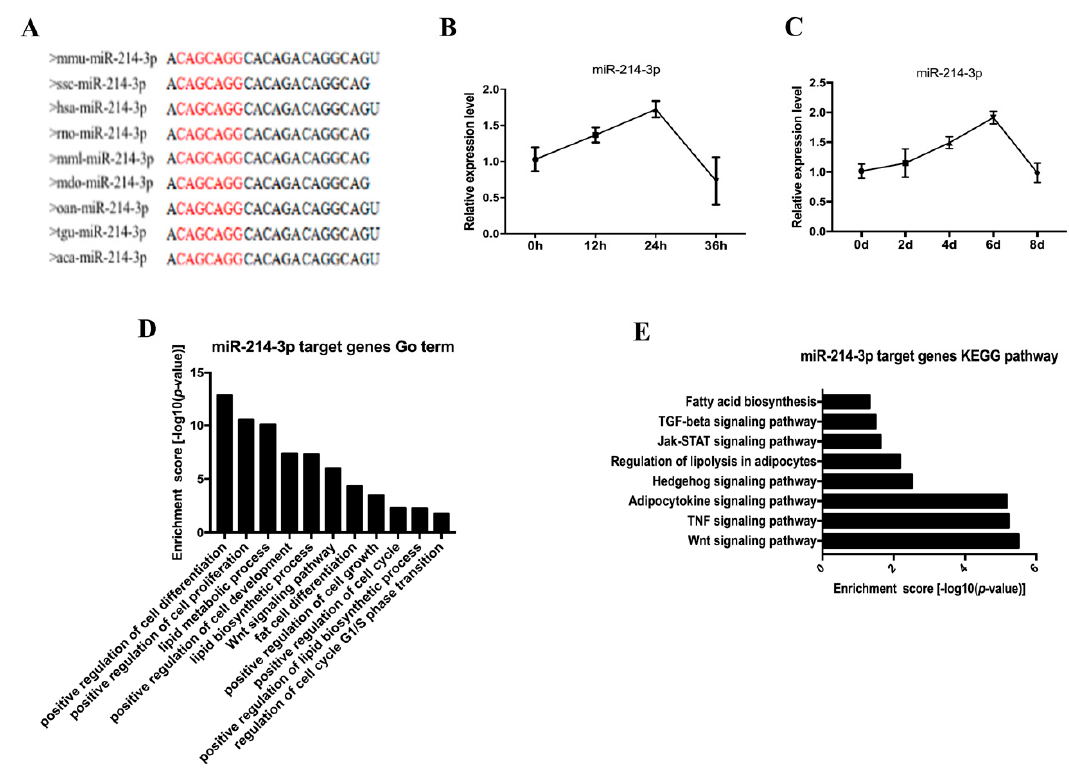
Figure 2. The level of miR-214-3p is up-regulated during 3T3-L1 adipogenesis. ( A ) The sequence of mature miR-214-3p is highly conserved across species; ( B ) RT-qPCR was performed to detect the expression of miR-214-3p during proliferation; ( C ) RT-qPCR analysis of miR-214-3p expression during adipogenic differentiation; ( D ) Go term analysis of the miR-214-3p targets; ( E ) KEGG pathway analysis of the miR-214-3p targets. Results were indicated as the mean ± SEM, n = 3. * p < 0.05; ** p < 0.01.